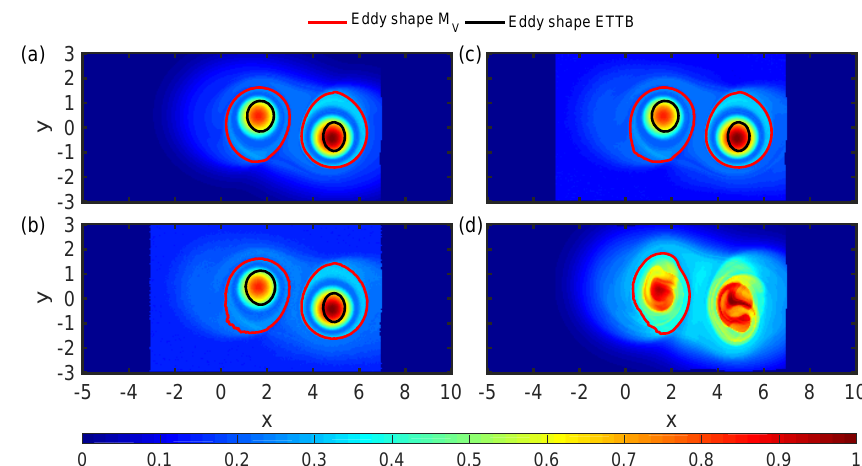
Figure 10. Eddy boundaries detected with the method based on M V (red line) and with the eddy tracking tool by Nencioli et al. (2010) (black line) at t = 0.201. (a) M V without noise, (b) M V with type 1 noise of noise level 0.95, (c) M V with type 2 noise of noise level 0.95, (d) M V with type 3 noise of noise level 0.5. The τ value is chosen as 0.15 T c with T c = 1. The dark blue regions are regions where the trajectories have left the region of interest. All plots are normalized to the maximum